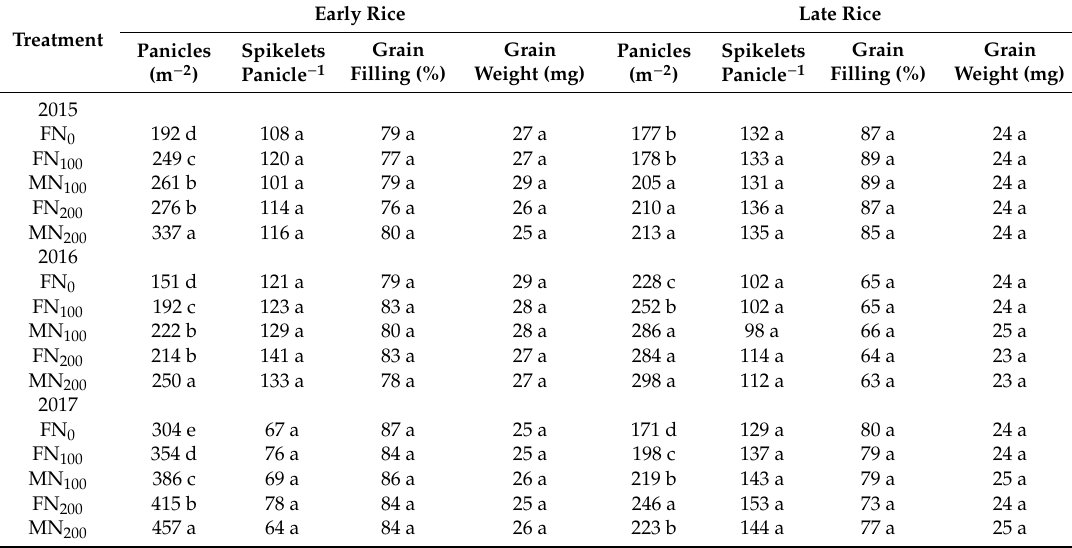
Table 3. Yield components for the early rice and late rice in the years 2015–2017 influenced by